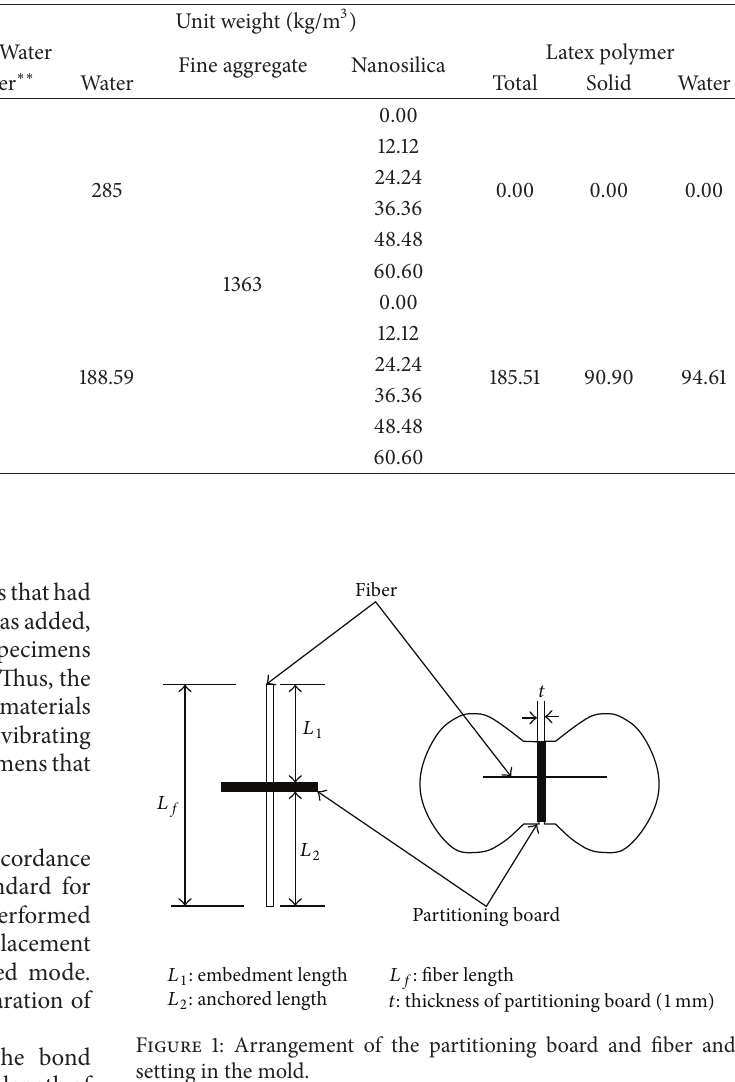
Table 5: Mix proportions.